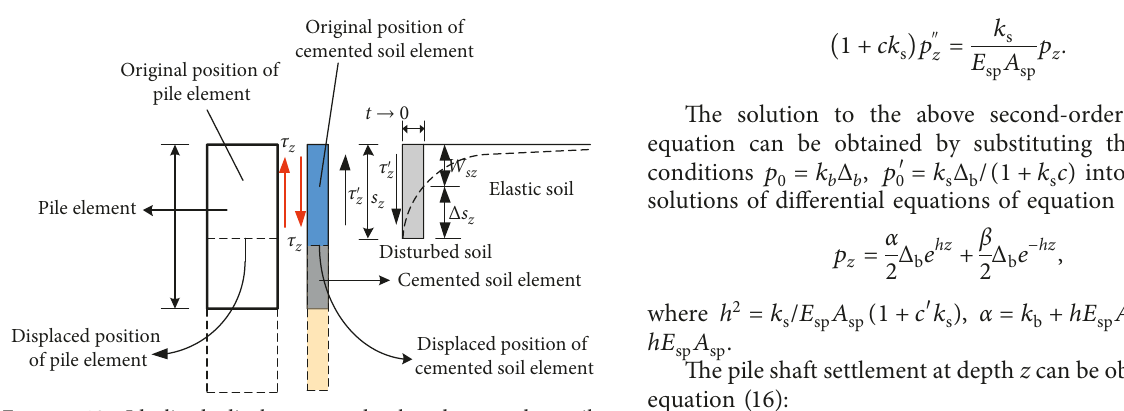
Figure 10: Idealized displacement developed around a pile